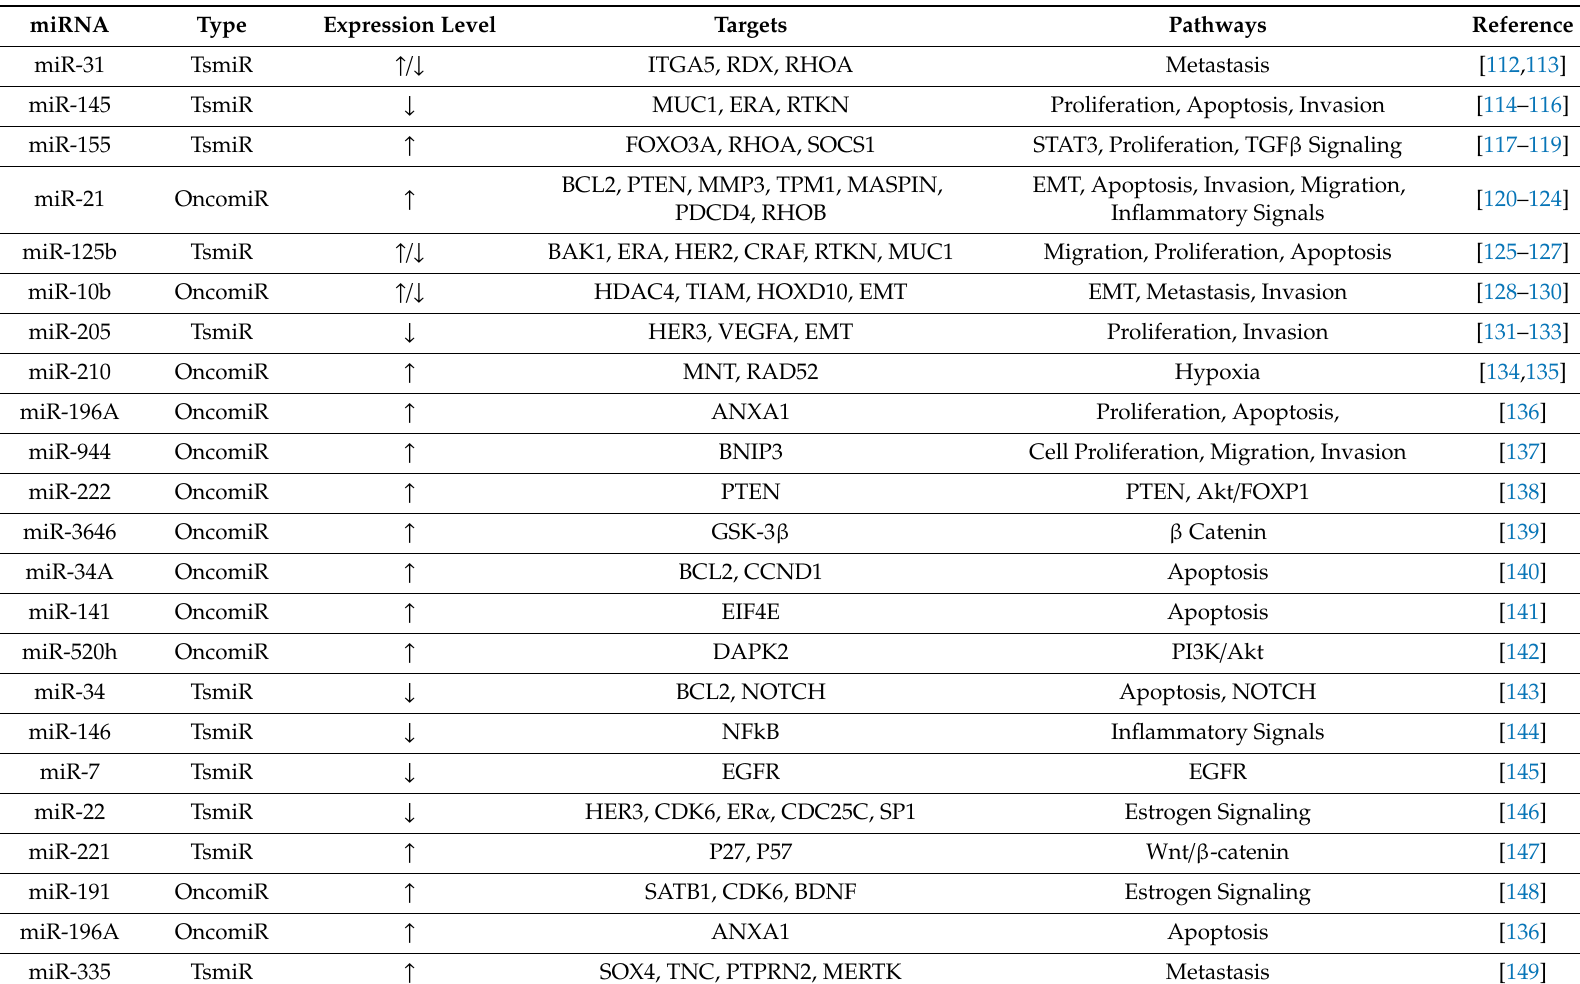
Table 1. Role of miRNAs acting as tumor suppressor / oncomir in BC with their targeted